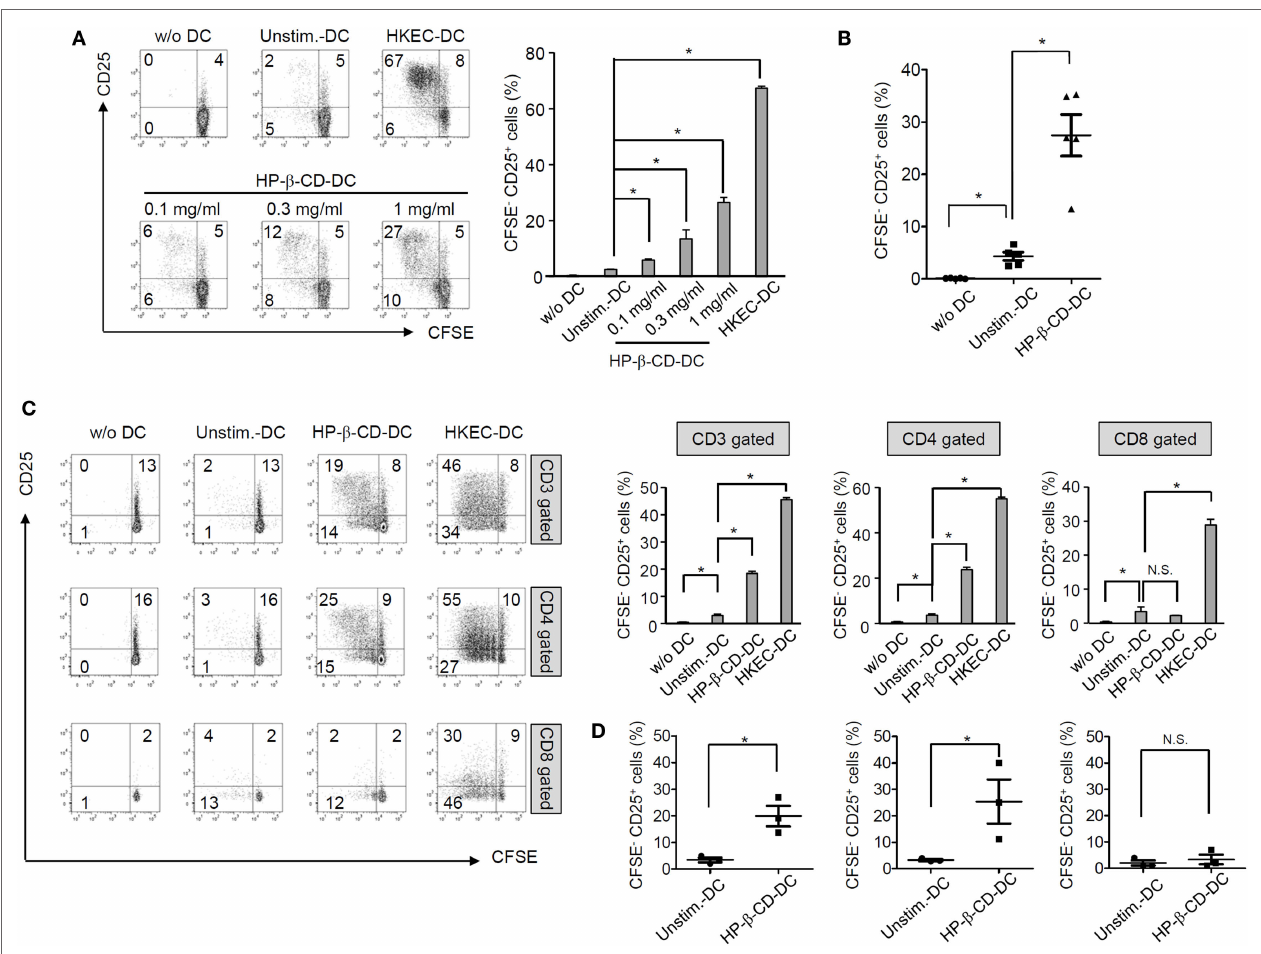
FigUre 2 | hP- β -cD-sensitized Dcs elicit the proliferation and activation of autologous T lymphocytes . Human monocyte-derived DCs (2.5 × 10 5 cells/ ml) were stimulated with HP- β -CD (0, 0.1, 0.3, or 1 mg/ml) for 16 h. Then, the cells (5 × 10 4 cells) were cocultured with CFSE-labeled autologous CD3 + T cells (5 × 10 4 cells) for 4 days. (a) T lymphocyte proliferation and CD25 expression were analyzed by flow cytometry. The bar graph beside the histograms displays the average of triplicate measurements for the proliferation of CD25 + T lymphocytes. (B) A scatter plot indicates activated T lymphocytes by DCs ( n = 5). (c) The proliferation and CD25 expression levels of CD3 + , CD4 + , or CD8 + T lymphocytes were analyzed by flow cytometry. The bar graphs on the right side of the histograms exhibit the average of triplicate measurements for the proliferation of CD25 + T lymphocytes. (D) Scatter plots exhibit activated CD3 + , CD4 + , or CD8 + T lymphocytes by DCs ( n = 3). The immune responses of T lymphocytes cultured with HKEC-stimulated DCs are shown as positive controls. The numbers on the histograms indicate the percentages of T lymphocytes in each quadrant. * P < 0.05. Unstim.-DC indicates T lymphocytes cocultured with unstimulated